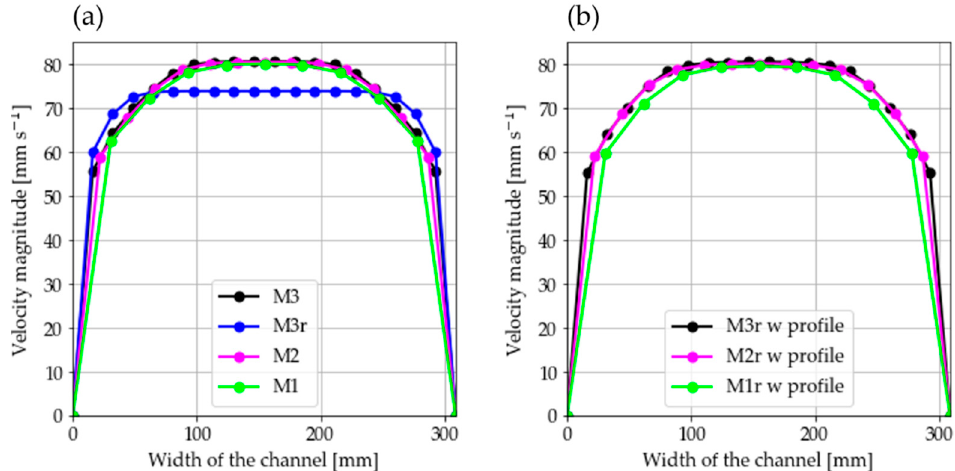
Figure 6. Horizontal velocity profiles of water: ( a ) comparison between three mesh densities for the full domain and the fine mesh of the reduced domain; ( b ) comparison between three mesh densities of the reduced domain with a velocity profile boundary condition.